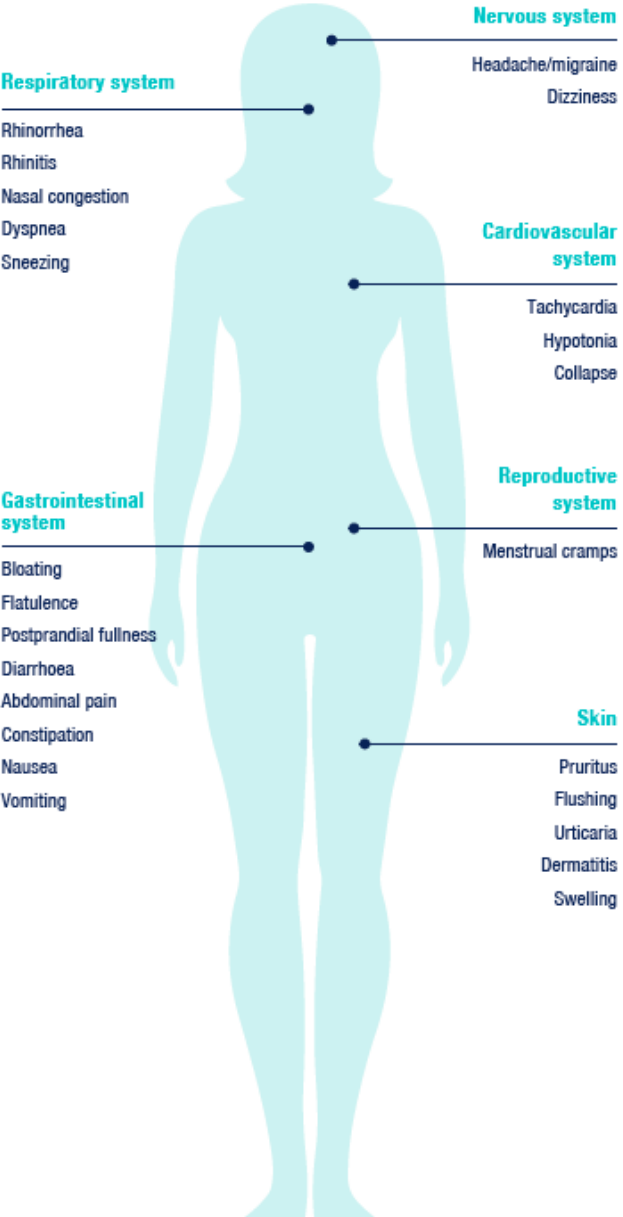
Figure 1. Typical manifestations related to the intake of exogenous histamine. Adapted according to [9].